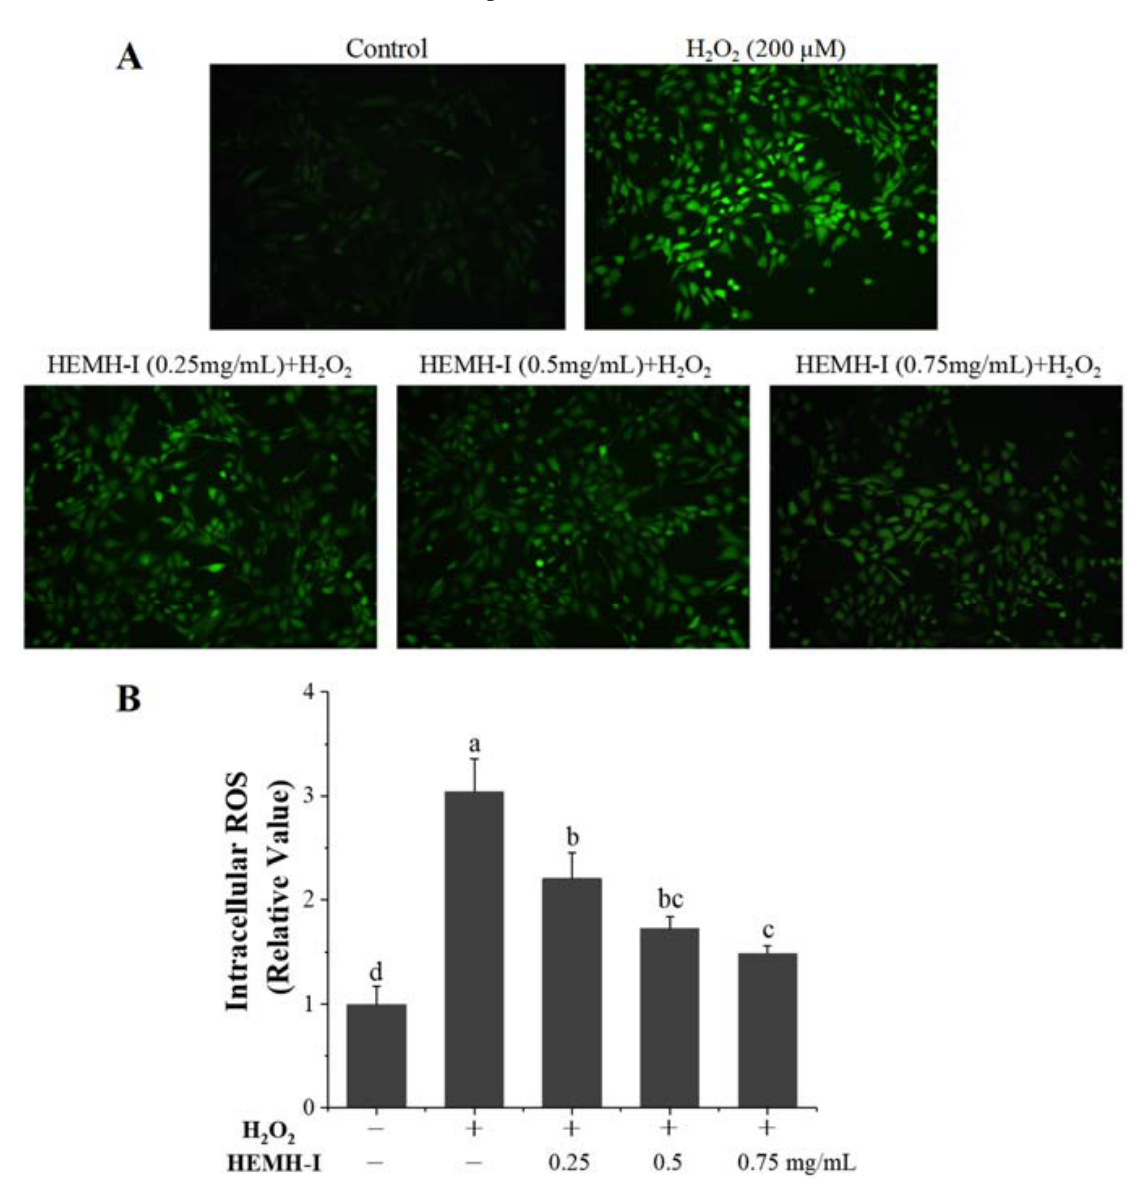
Figure 6. Effect of HEMH-I on ROS generation in the H 2 O 2 -induced SW1353 cells. ( A ) Fluorescence micrograph; ( B ) Fluorescence intensity of different groups. Values are expressed as mean ± SD ( n = 5). Different letters (a–d) mean significant differences ( p < 0.05).